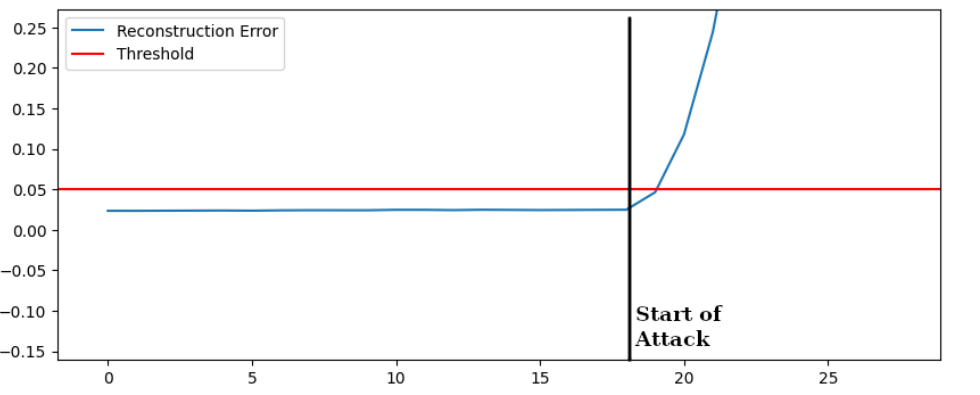
Figure 9. Reconstruction Error—Bad Data Injection Voltage.